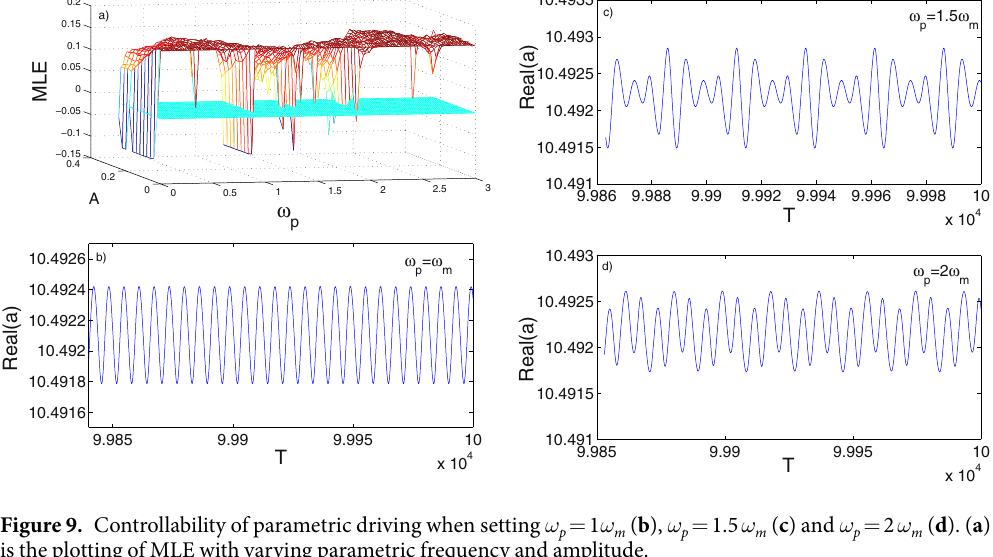
Figure 9. Controllability of parametric driving when setting ω p = 1 ω m ( b ), ω p = 1.5 ω m ( c ) and ω p = 2 ω m ( d ). ( a ) is the plotting of MLE with varying parametric frequency and amplitude.